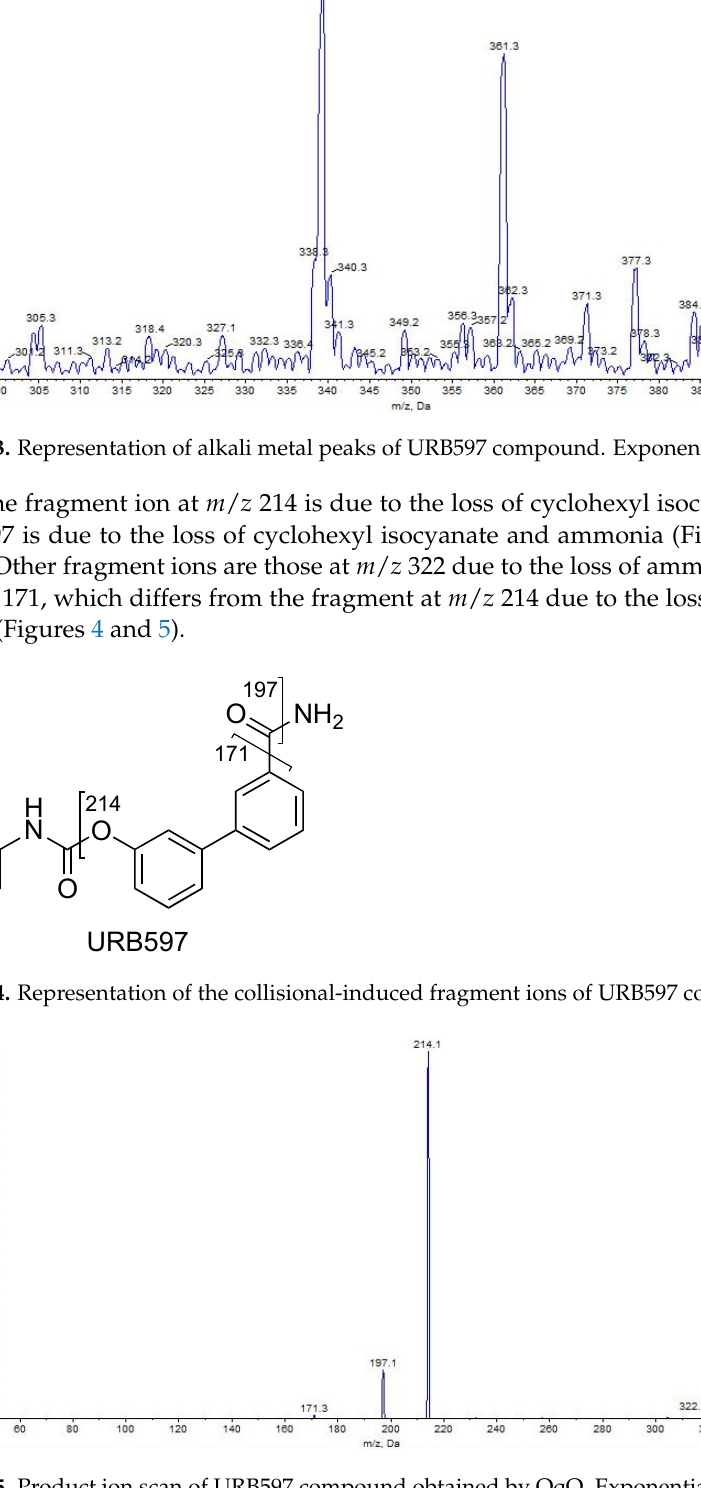
Figure 6. Product ion scan of URB597 compound obtained by HRMS. 2.2. URB937 URB937 differs from URB597 by the presence of a 6–hydroxy group on the proximal phenyl ring. URB937 ([M + H] + m / z 355) shows the same fragmentation pattern as URB597, displaying fragment ions at m / z 377 [M + Na] + and m / z 393 [M + K] + but more affinity with alkali metal (Figure 7).